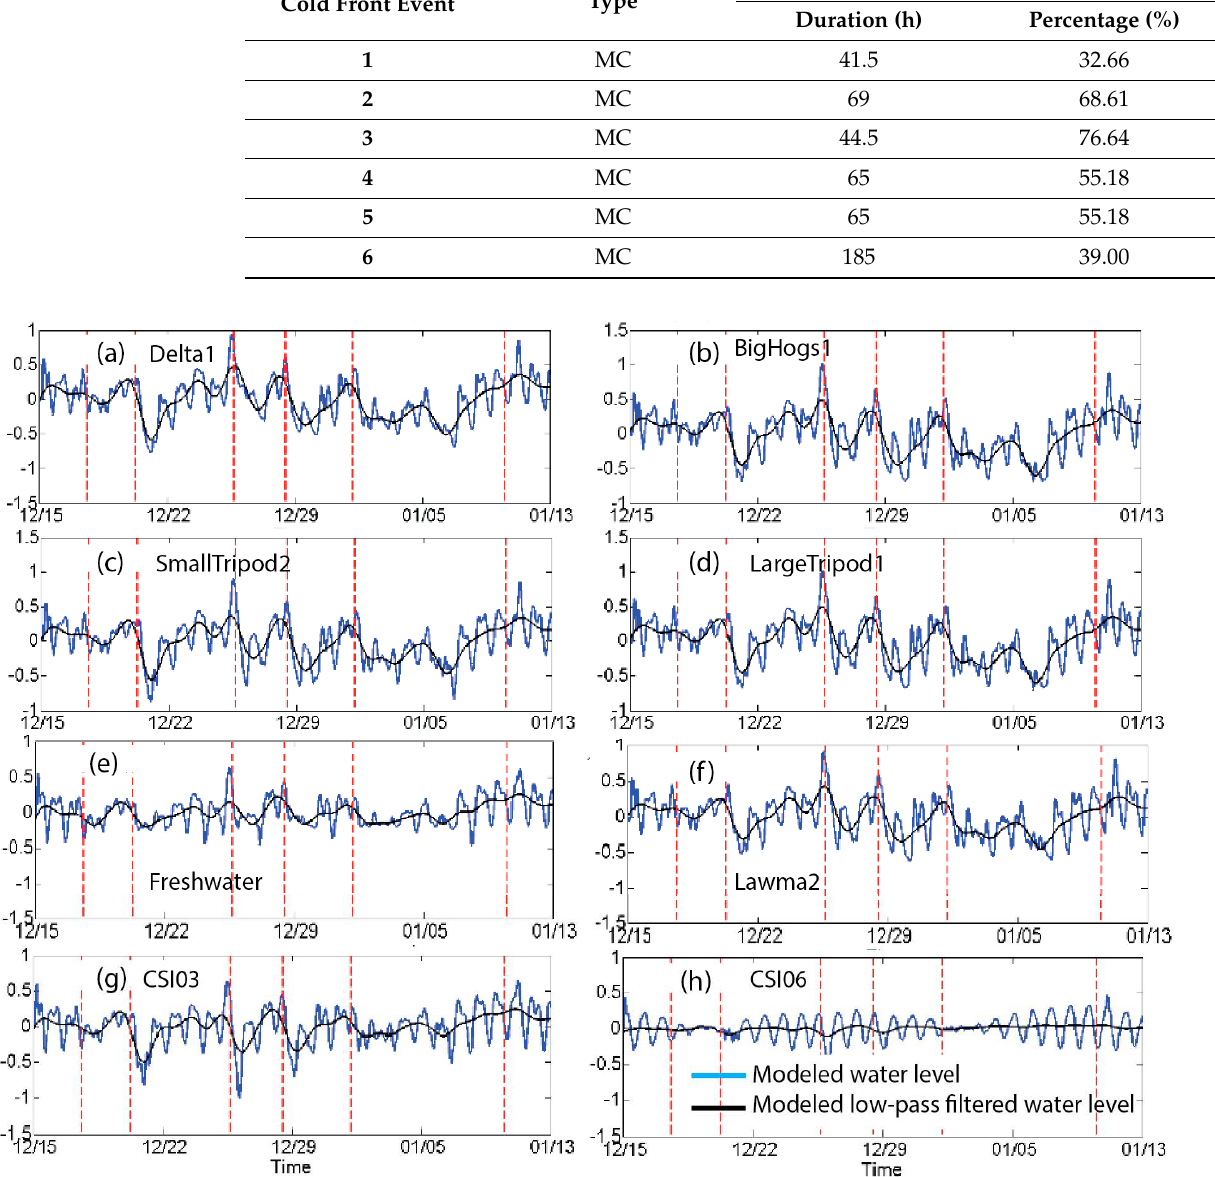
Table 5. The duration, total volume transport, and percentage of volume flushed out during six cold fronts. MC: migrating cyclone. (The ‘+’ sign means the cold front is still going on.)